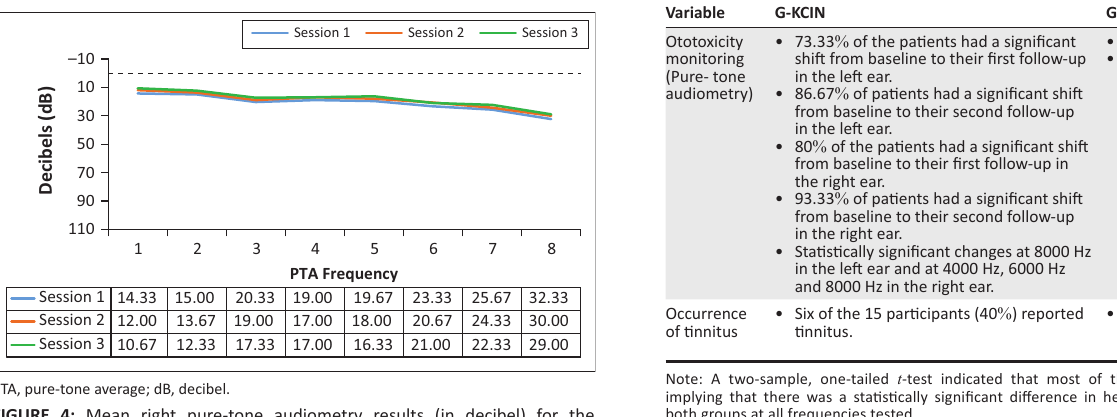
TABLE 3: Table depicting comparison of results in both